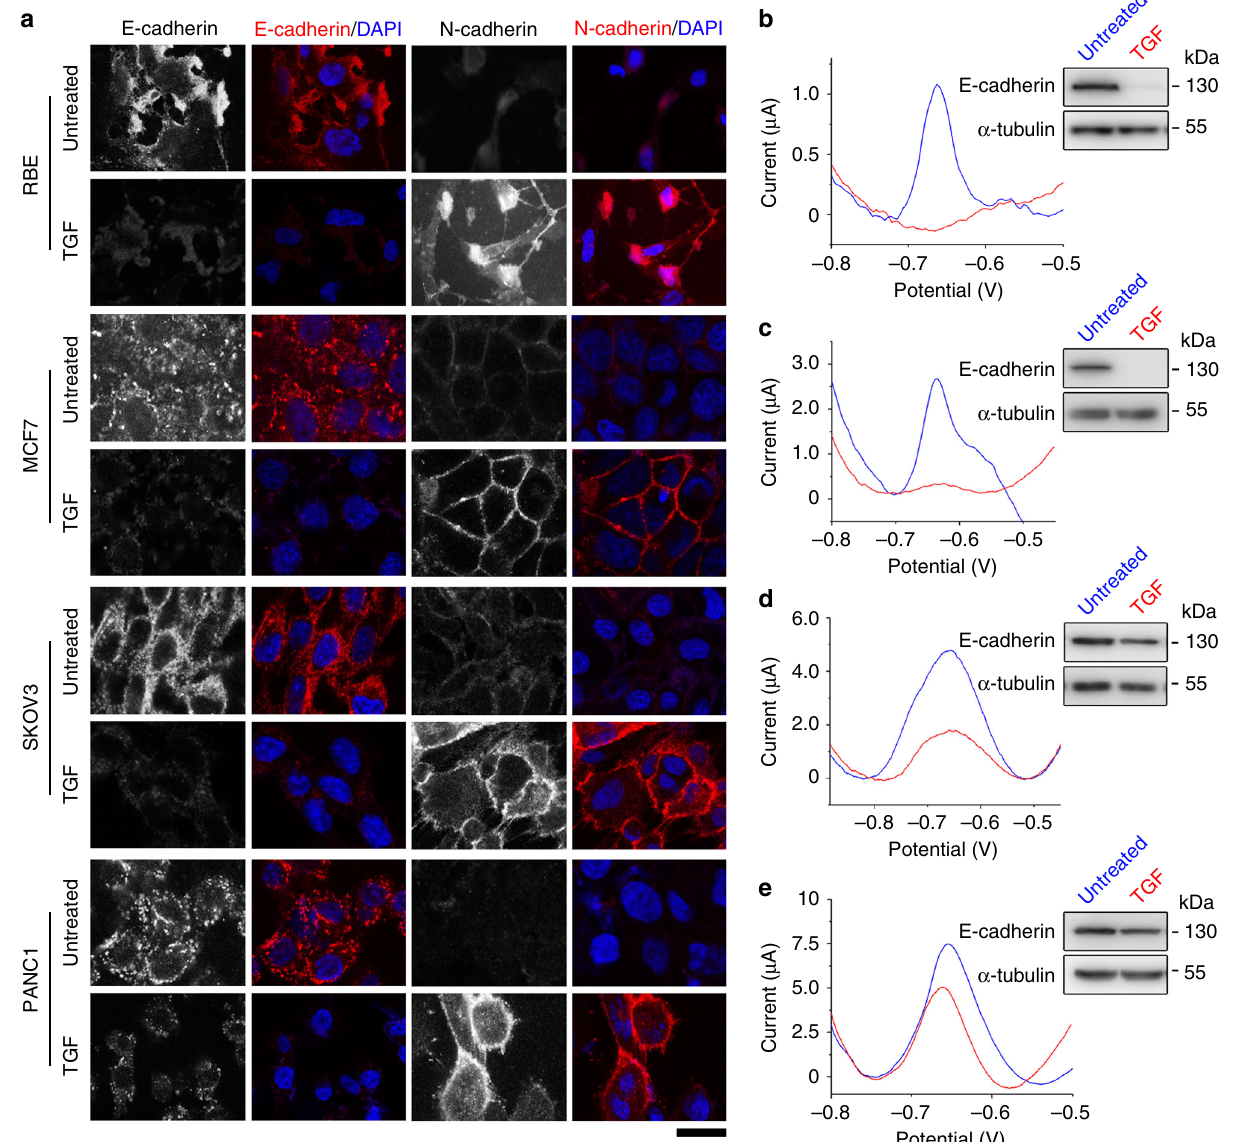
Fig. 7 The EMT biosensor is applicable in multiple cell lines. a Immuno fl uorescence microscopy of E-cadherin and N-cadherin in RBE, MCF7, SKOV3, and PANC1 cells treated or untreated with TGF. Scale bar, 25 μ m. b – e Electrochemical detection of RBE b , MCF7 c , SKOV3 d , and PANC1 e cells using the prepared biosensor. Upper right, immunoblots showing E-cadherin and α -tubulin levels in cells treated or untreated with TGF. Source data are provided as a Source Data fi